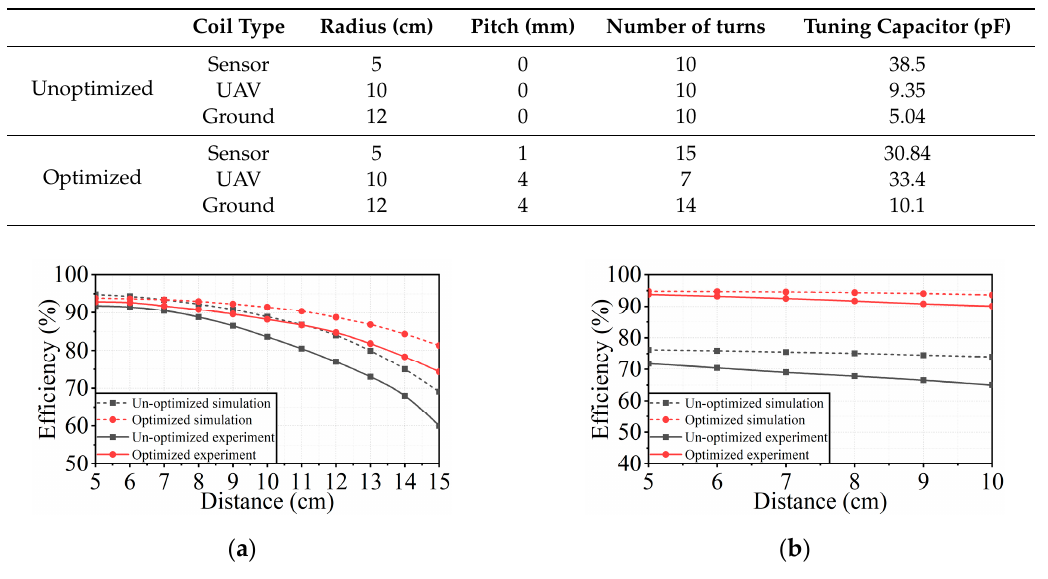
Table 1. Unoptimized and optimized coil parameters.